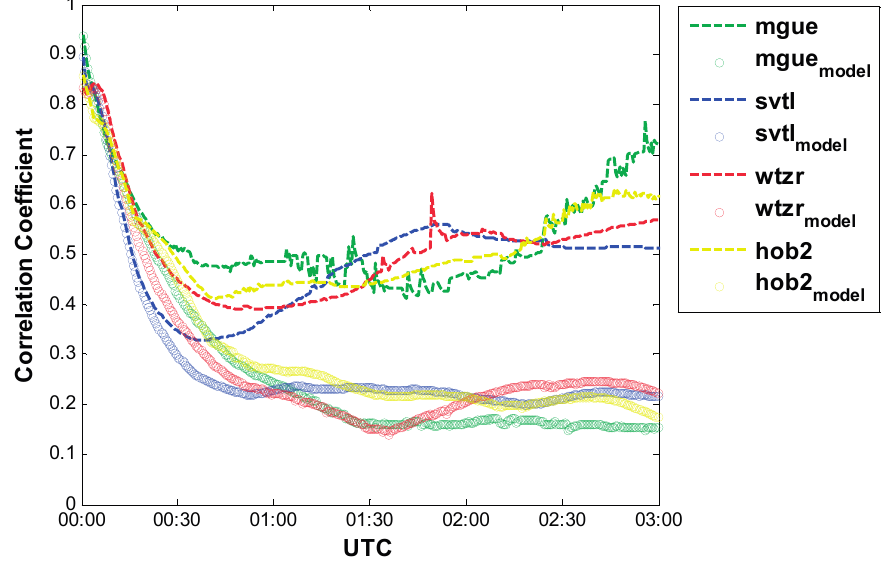
Figure 2. Correlation coefficients between the receiver clock offset and height coordinate (Model 2 vs. Model